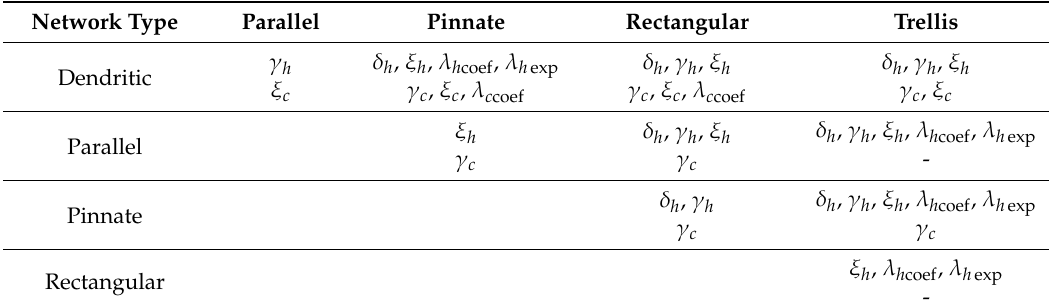
Table 2. Distribution parameters that exhibit significant di ff erences between the network types based on the analysis of variance (ANOVA) and analysis of covariance (ANCOVA) tests. For each pairing of network types, the top row reports parameters for A sh , and the bottom row reports parameters for A sc . Network Type